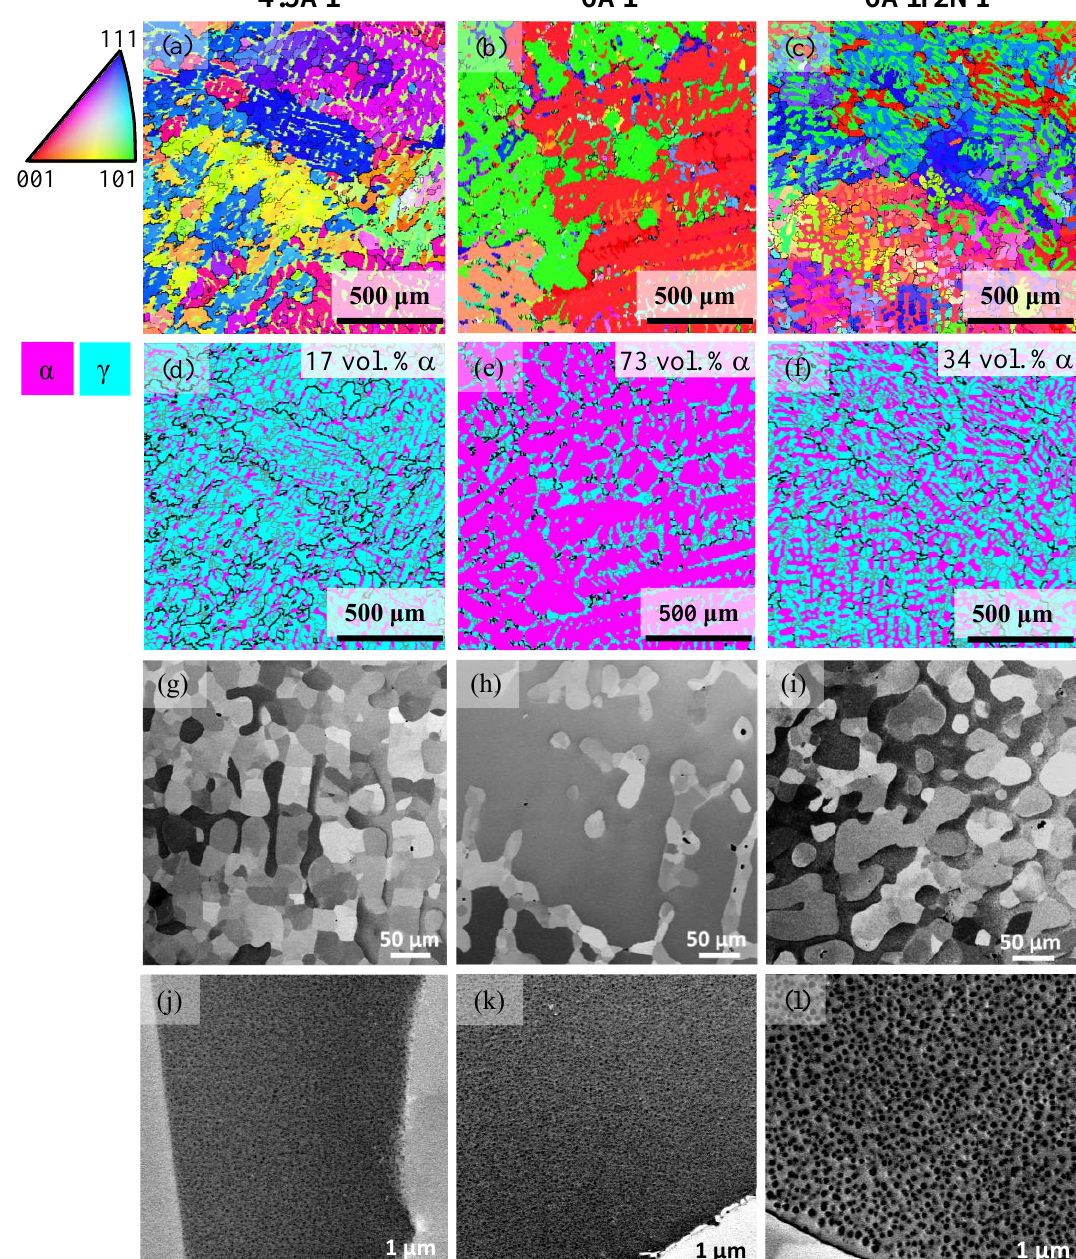
1 μ m Figure 7. EBSD IPF maps ( a – c ), EBSD phase maps ( d – f ), and SEM micrographs ( g – l ) for the homog- enized steels with duplex matrix microstructures; ( a , d , g , j ) 4.5Al steel, ( b , e , h , k ) 6Al steel and ( c , f , i , l ) and gray lines superimposed on EBSD phase maps indicate HAGBs (misorientation angles larger